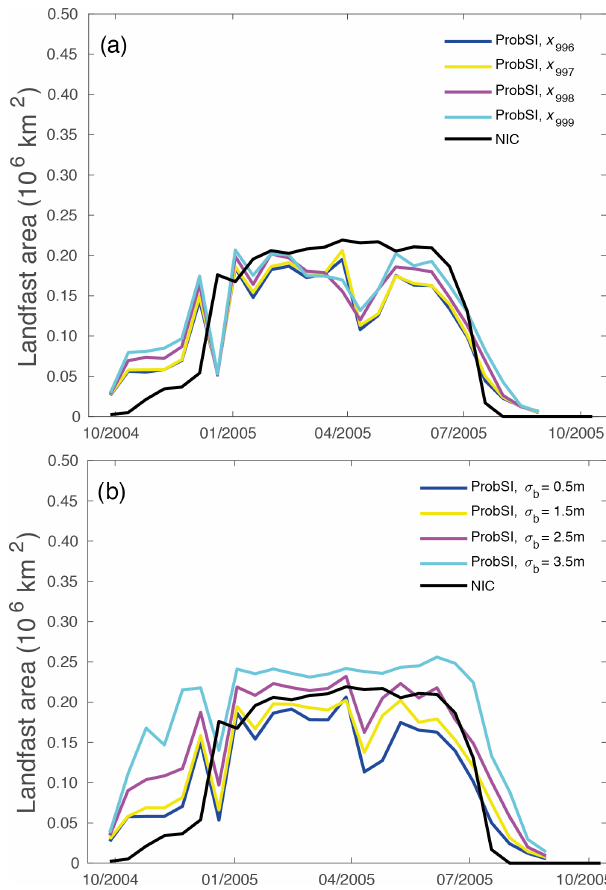
Figure 6. Area of landfast ice in Laptev Sea during winter 2004– 2005 simulated with the ProbSI formulation and compared to NIC data. Panel (a) shows results with σ b = 0 . 5m and different values of x p , while panel (b) shows results with x 997 and different values of σ b